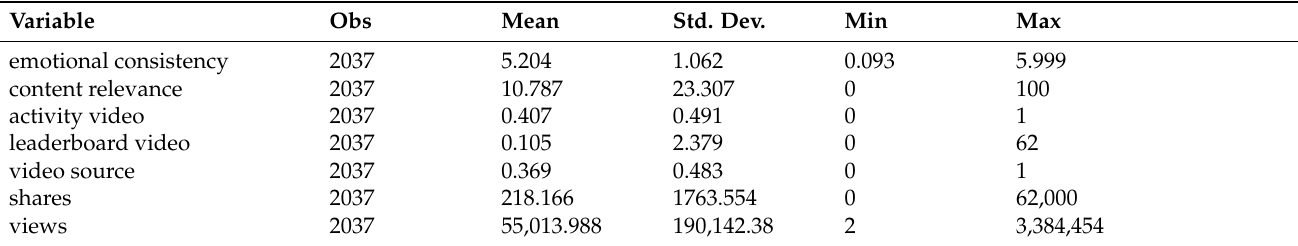
Table 2. Summary Statistics.